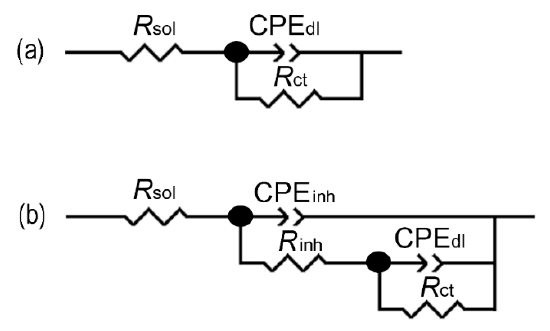
Figure 21. Electrochemical impedance spectroscopy (EIS) equivalent circuits used for numerical simulation of the EIS data obtained for the mild steel panels after submission in the electrolytic solutions in the absence or presence of corrosion inhibitors: ( a ) equivalent circuit with three elements, ( b ) equivalent circuit with five elements.